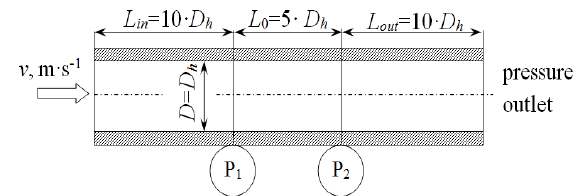
Fig. 2 Model of stright duct